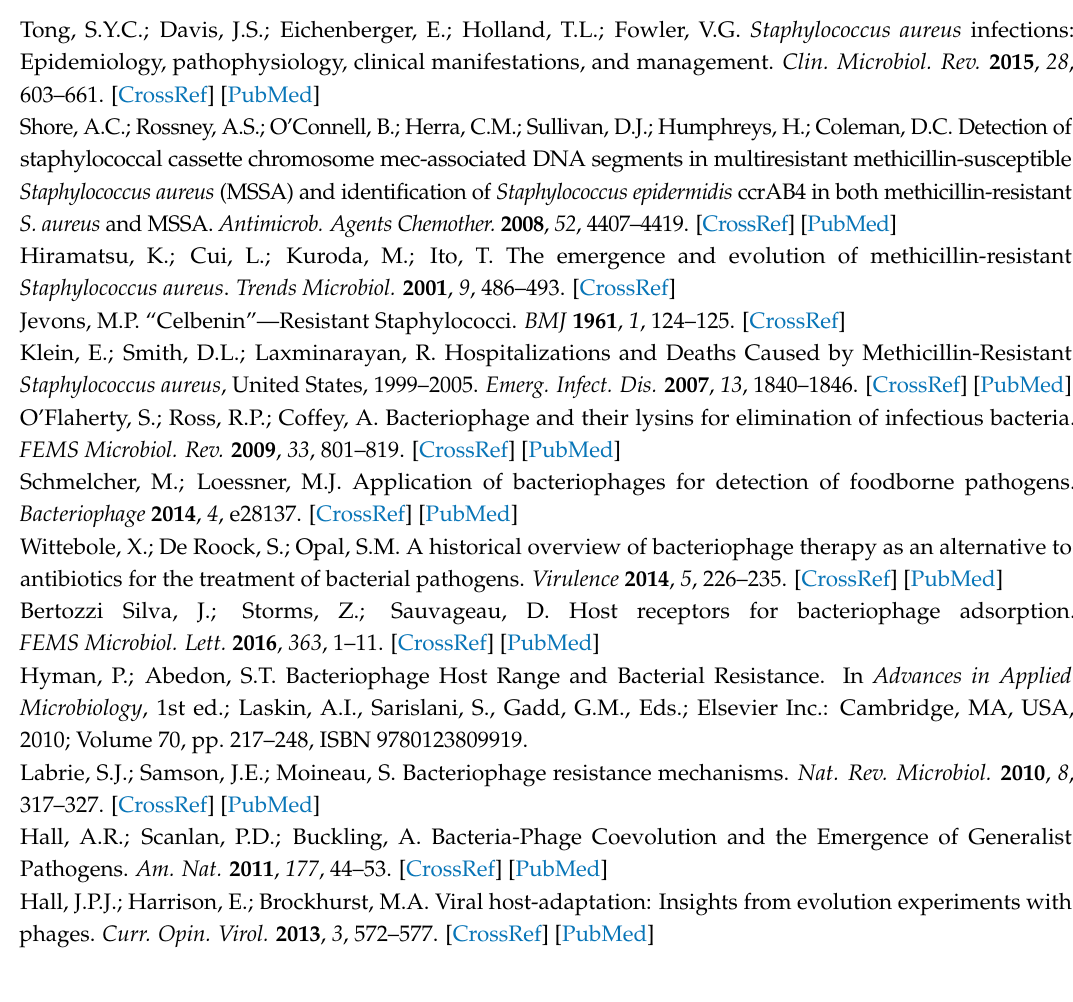
Figure S1: Plaque morphologies of phages B1, JA1 and K with common morphology types encountered in their host range study to include plaques sizes of 2mm (A), 0.5mm (B) and 1.0mm (C), Figure S2: Staphylococcus phage K adsorption to strains of Staphylococcus aureus resistant to infection by, in comparison host strain DPC5246, Figure S3: Comparison of regions within the genome of phage K to closely related staphylococcal phages, Table S1: Annotation of the staphylococcal phage vB_SauM_B1, Table S2: Annotation of the staphylococcal phage Table S4: Predicted Rho-like promoters of Staphylococcus phage JA1 genome found using MEME, Table S5: High ∆ G rho-independent terminators predicted in the genome Staphylococcus phage B1 identified using ARNold and QuikFold, Table S6: High ∆ G rho-independent terminators predicted in the genome Staphylococcus phage JA1 identified using ARNold and QuikFold, Table S7: Percentage similarity based on BLASTN of broad host range Staphylococcus phages that form commercial phage cocktails to that of Staphylococcus phage K, Table S8: tRNA genes of phages B1, JA1, K, vB_SauM-fRuSau02, ISP, Sb-1, Team